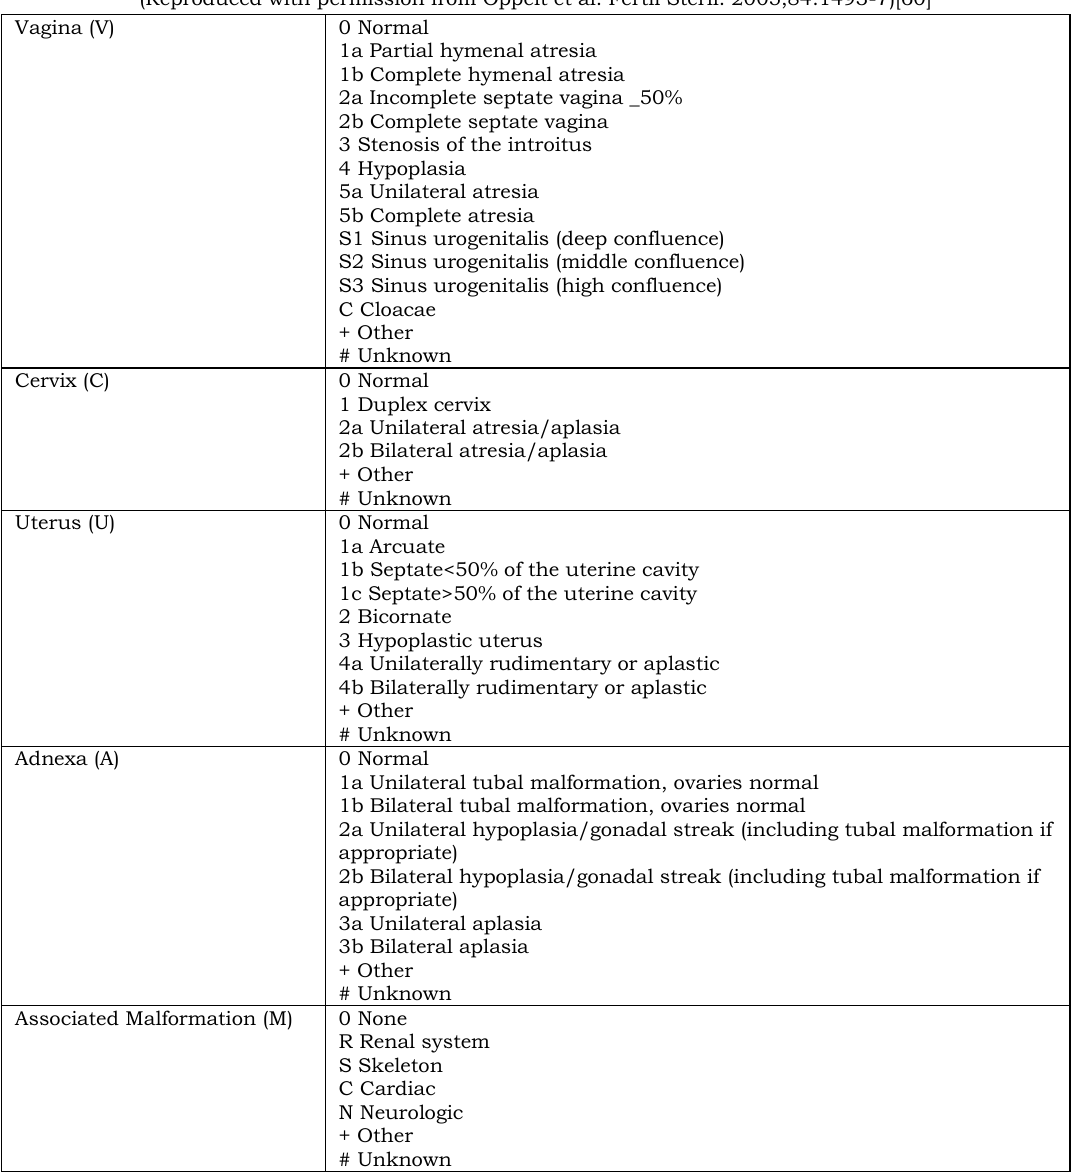
Table 2: VCUAM classification of genital malformations- Description of the individual malformations relative to the organ. (Reproduced with permission from Oppelt et al. Fertil Steril. 2005;84:1493-7)[60] Vagina (V) 0 Normal 1a Partial hymenal